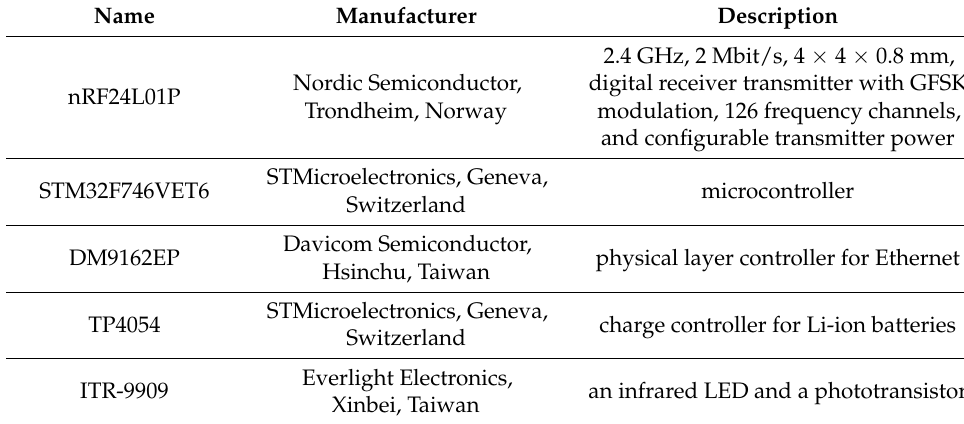
Figure 8. Slot for inserting the wireless module: ( a ) top view, ( b ) bottom view; location of the wire- less module for fixing in the slot of the base station: ( c ) top view, ( d ) bottom view, ( e ) dedicated